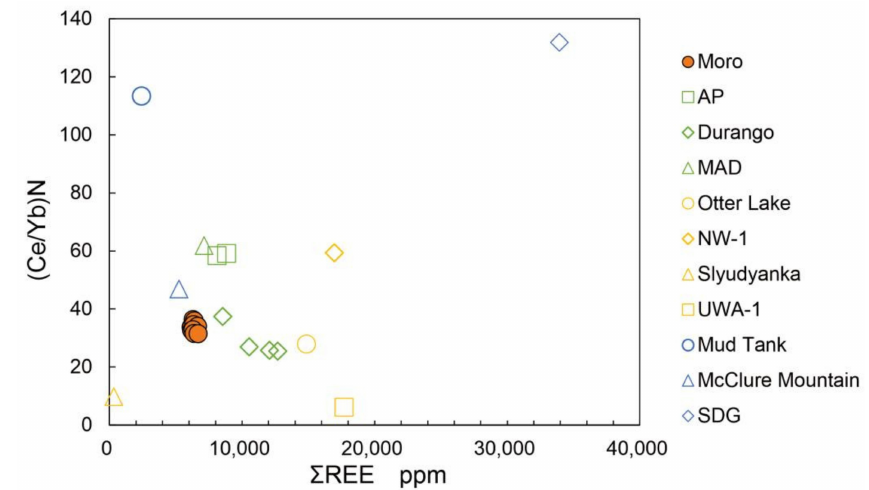
Figure 10. Σ REE–(Ce/Yb) N of apatites from different